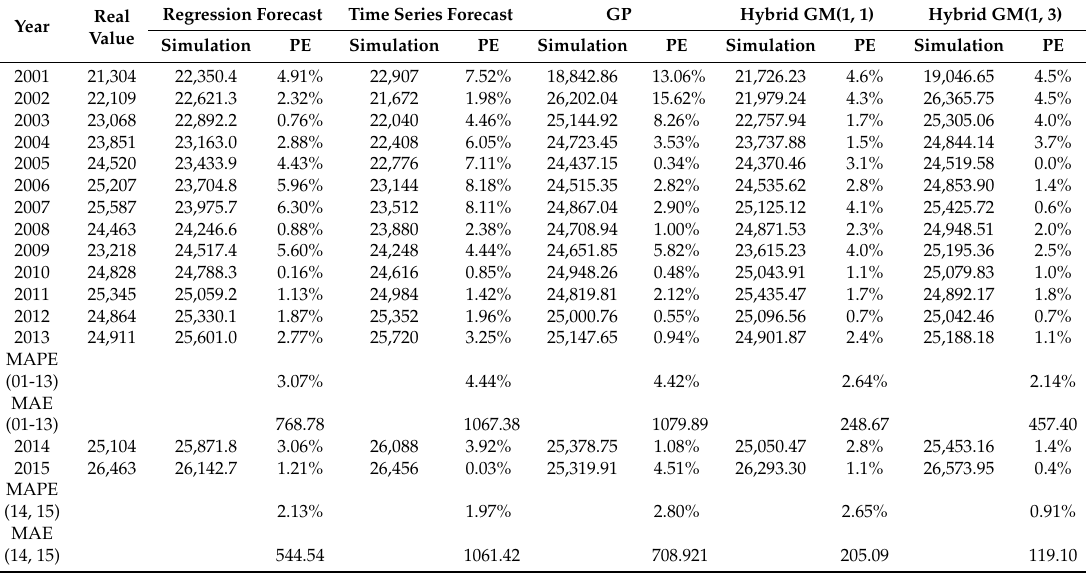
Table 6. Comparison of five forecast models trained with the data from 2000–2013 and tested with the data from